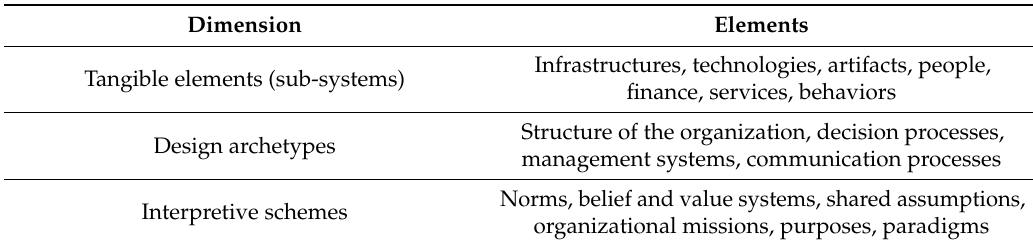
Table 1. Dimensions of organizations (based on Laughlin’s [81]